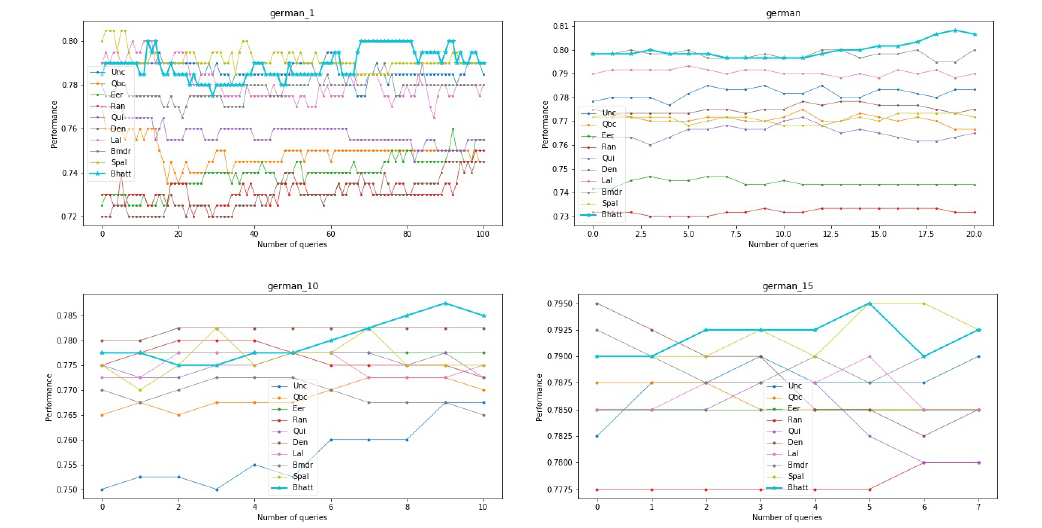
Figure 3. Performance comparison on the German dataset, compared with single active learning; batch active learning is more efficient while maintaining higher